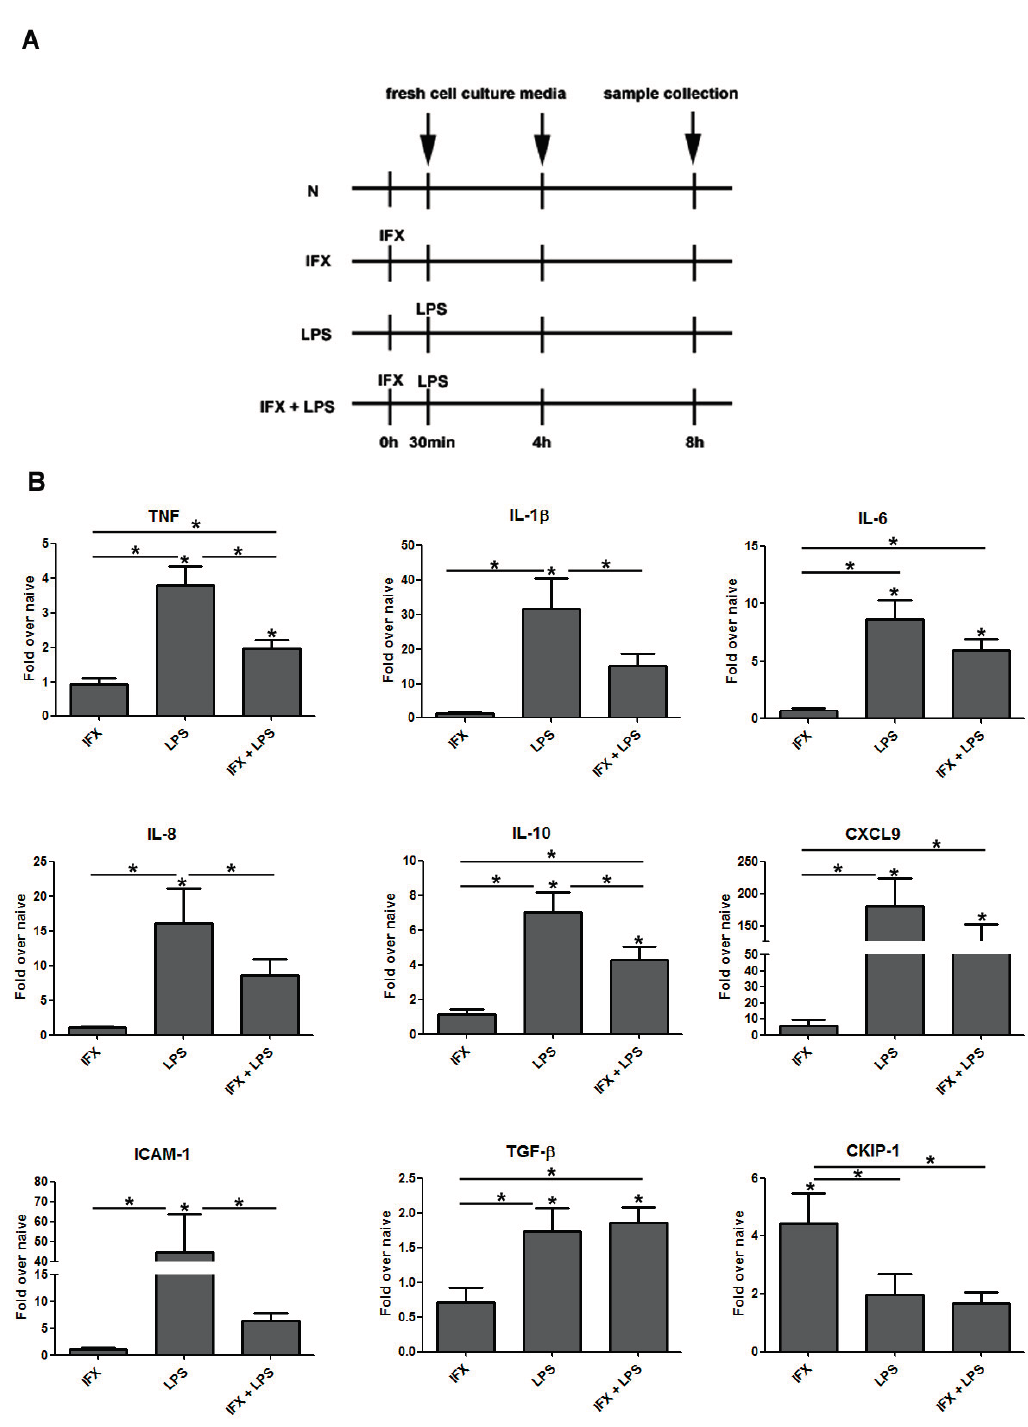
Figure 1. The induction of reverse signaling with IFX on THP-1 cells alters the expression pattern of inflammation-related effector molecules. ( A ) THP-1 human monocytes were treated with IFX and/or LPS. Total RNA and cell culture supernatants were collected 8 h post-IFX treatment. ( B ) IFX treatment alone had no significant impact on relative gene expression pattern of the genes, with the notable exception of CKIP-1. The CKIP-1 protein is involved in inflammation and in reverse signaling. Bars show means ± SEM from at least three independent experiments. * Significantly different from controls (One-Way ANOVA, following the Neuman–Keuls post hoc